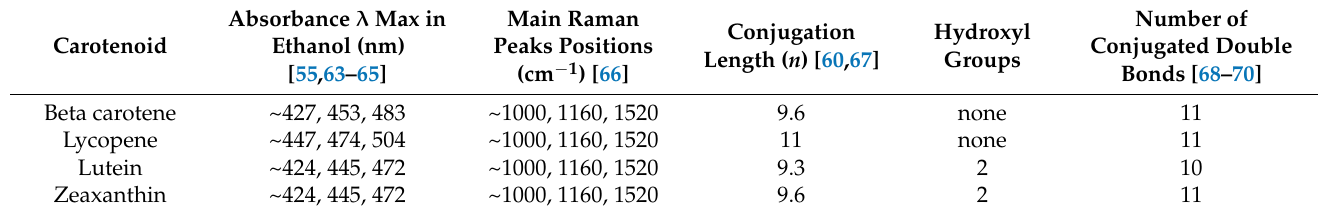
Table 3. Summary of some optical and chemical properties of